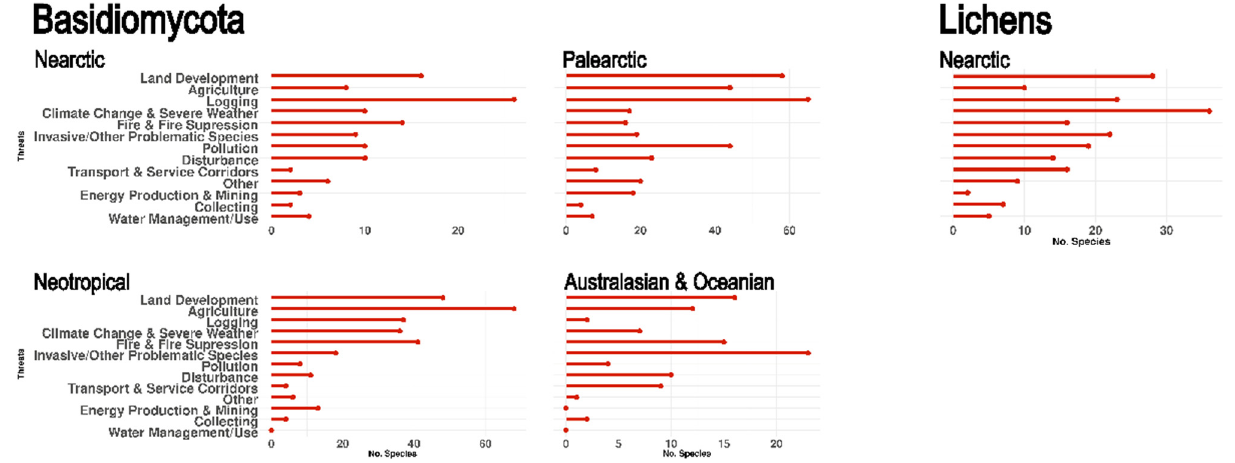
Figure 11. Threats identified for globally threatened and near-threatened Basidiomycota and lichens in the different biogeographic realms. This compilation was based on the qualitative listing of threats for each assessed species, and the relative size of the bars does not reflect the relative significance of each threat. NT species are included, as understanding their threats is needed to mitigate further population loss.